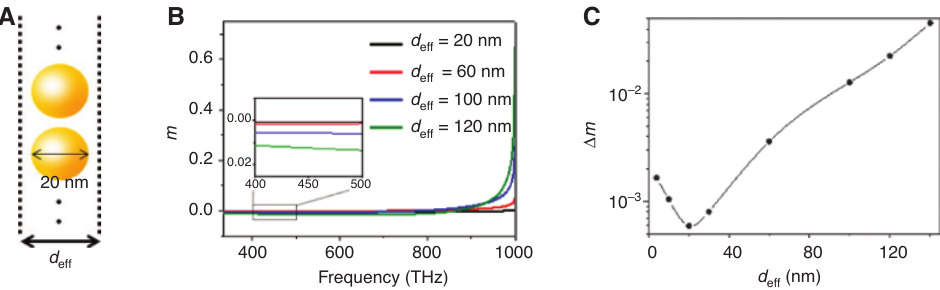
and the branch m . eff . eff